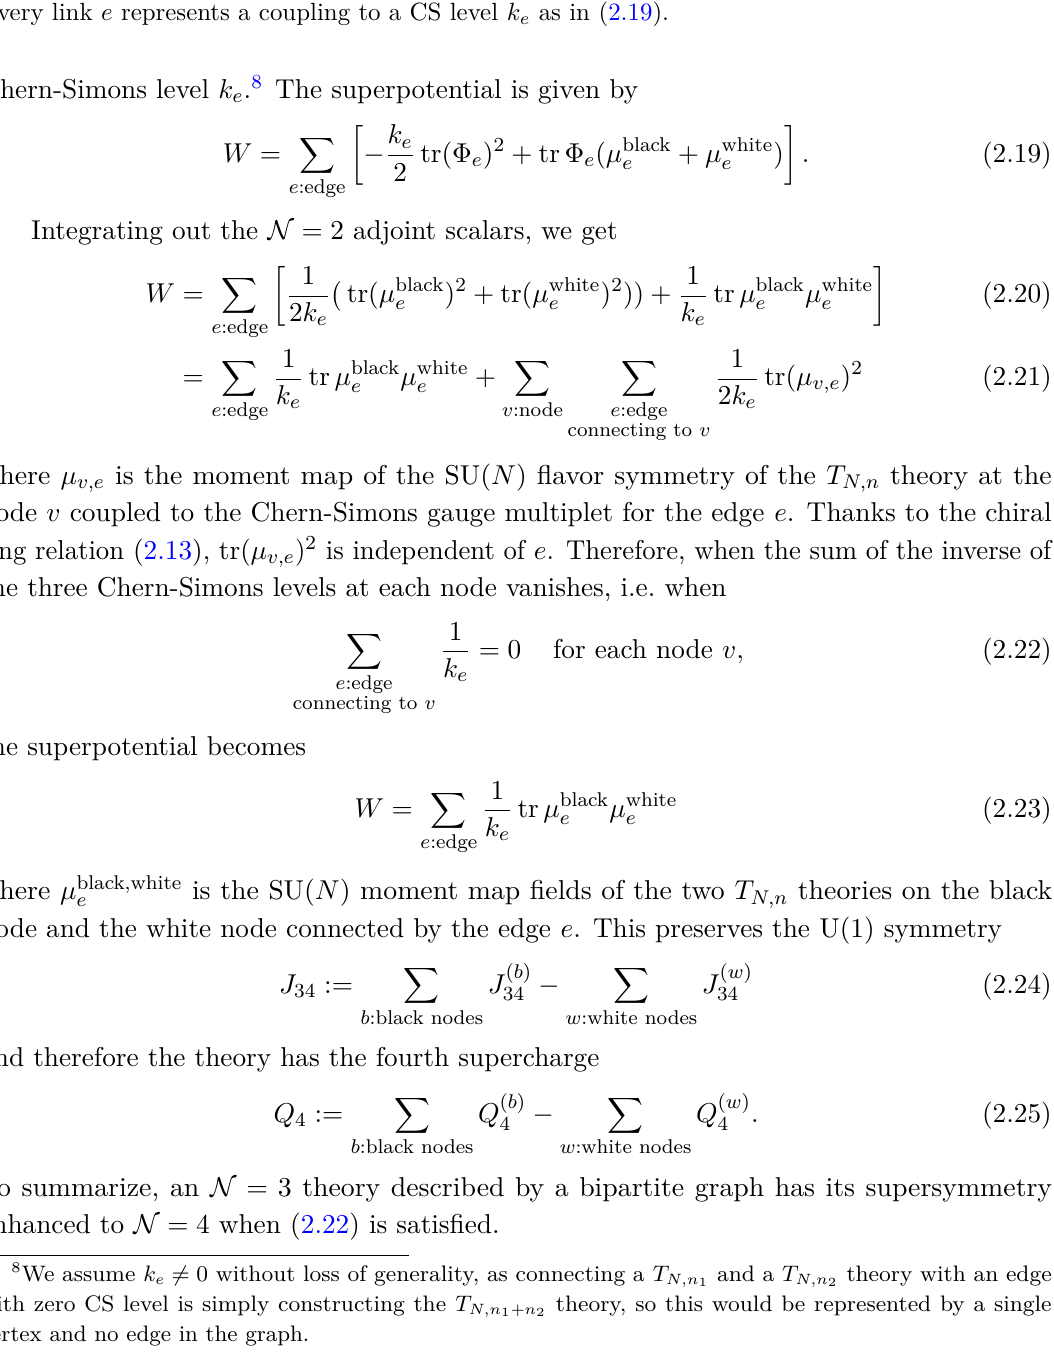
Figure 3 . A graph encoding the coupling of T N,n theories and N = 3 Chern-Simons multiplets. Every link e represents a coupling to a CS level k